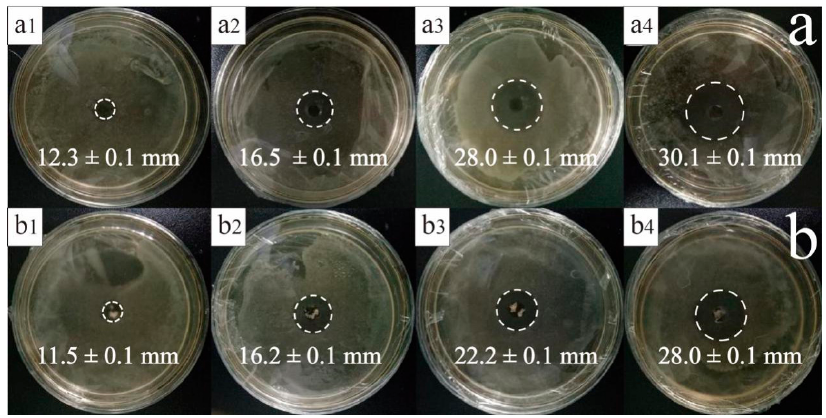
Table 2. Fitting results for release curves at various monomer